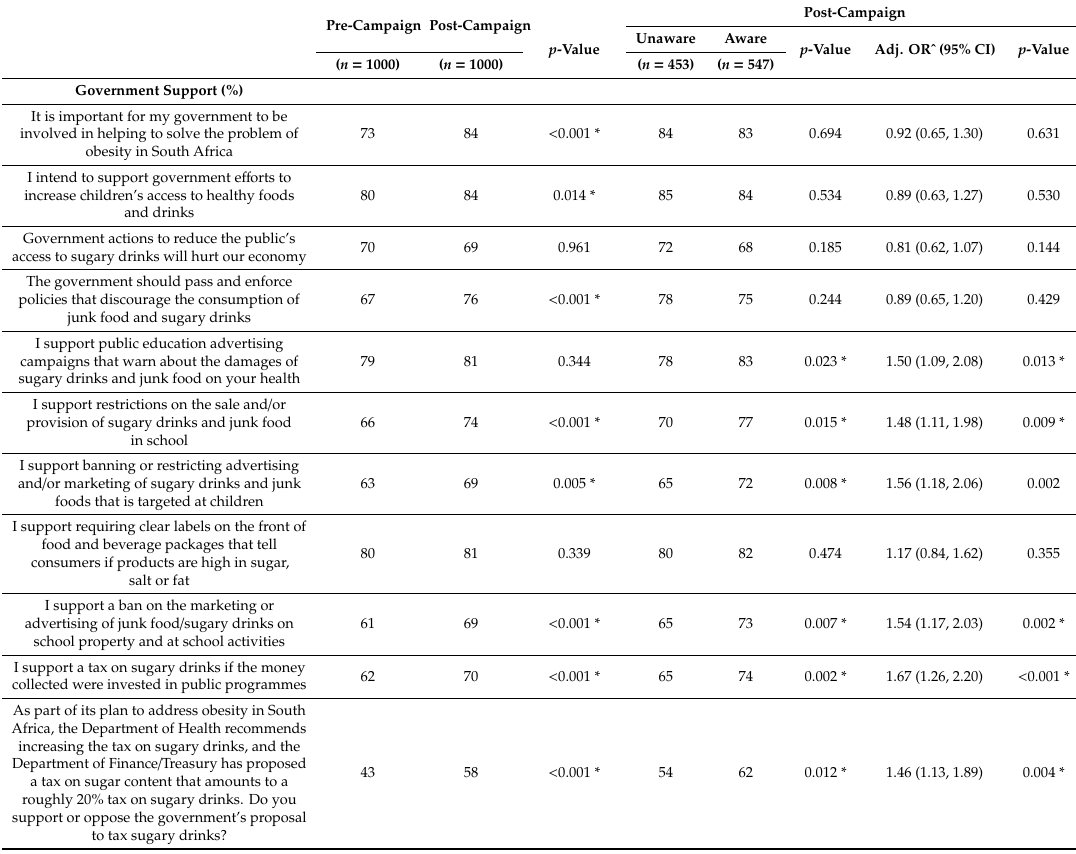
Table 5. Support for the government’s e ff orts regarding obesity and sugary drinks among respondents in the pre-campaign and post-campaign periods, including a comparison of post-campaign respondents who were aware and unaware of the campaign.